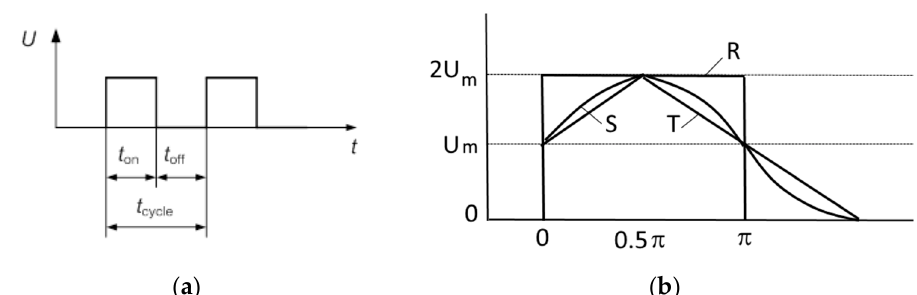
t t t t t = + ( а ) and forms of pulses Figure 1. Duty cycle (DC) parameter determination DC= / / ( ) Figure 1. Duty cycle (DC) parameter determination DC = t on / t c = t on / ( t on + t of f ) ( a ) and forms of on c on on off pulses ( b ) R is a rectangular, S is a sinusoidal and T is a triangular form of ( b ) R is a rectangular, S is a sinusoidal and T is a triangular form of pulses.